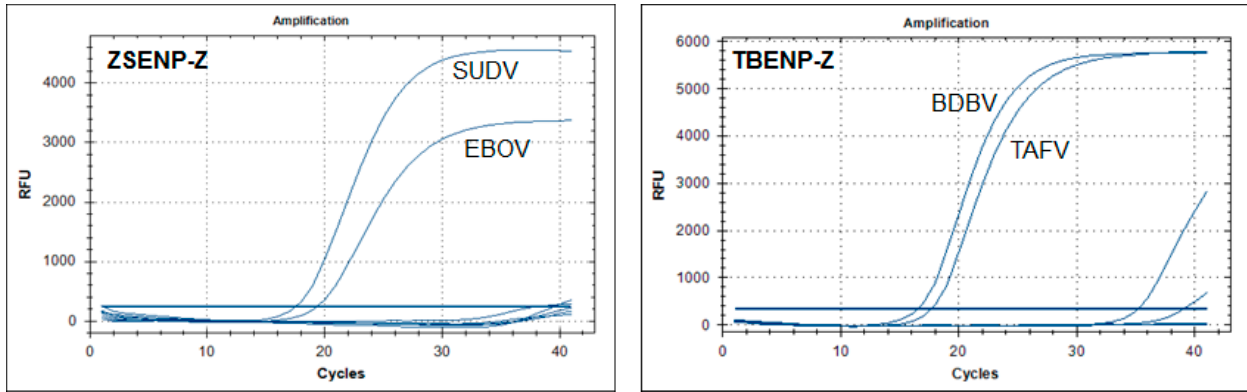
Figure 1. Specificities of the ZBENP-Z and TBENP-Z assays were examined using a variety of mimic viral RNA including Marburg virus (MARV), SUDV, TAFV, BDBV and RESTV. They were designed to be simultaneously specific for two EBOV species: ZSENP-Z for EBOV and SUDV, whereas TBENP-Z for TAFV and BDBV RFU: relative fluorescence units.